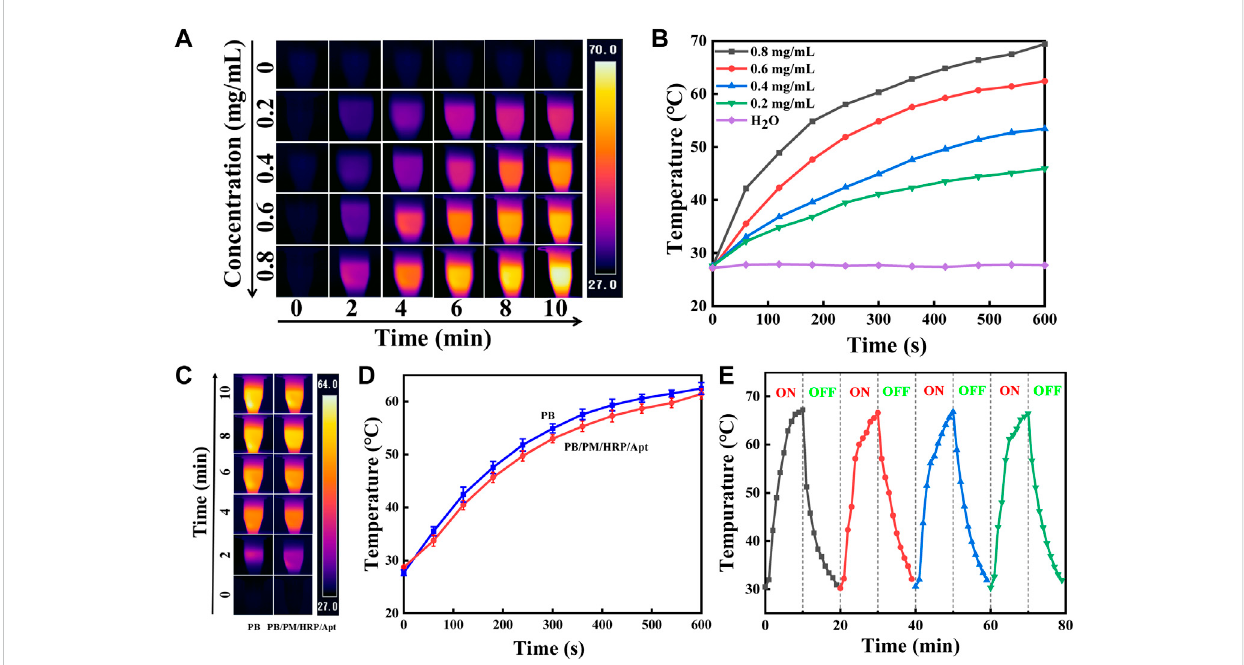
FIGURE 3 Characterization of photothermal properties of PB/PM/HRP/Apt. (A) Infrared thermal images of PB/PM/HRP/Apt at different concentrations (0 – 0.8 mg/ml, 2 W cm − 2 ). (B) Concentration dependence curve of PB/PM/HRP/Apt (0 – 0.8 mg/ml, 2 W cm − 2 ). (C) Infrared thermogram of PB and PB/ PM/HRP/Apt exposed to 808 nm laser for 10 min (0.6 mg/ml, 2 W cm − 2 ). (D) Temperature rise curve of PB and PB/PM/HRP/Apt (0.6 mg/ml, 2 W cm − 2 ). (E) Temperature variation of PB/PM/HRP/Apt under repeated laser irradiation for four consecutive heating-cooling cycles (10 min irradiation for each